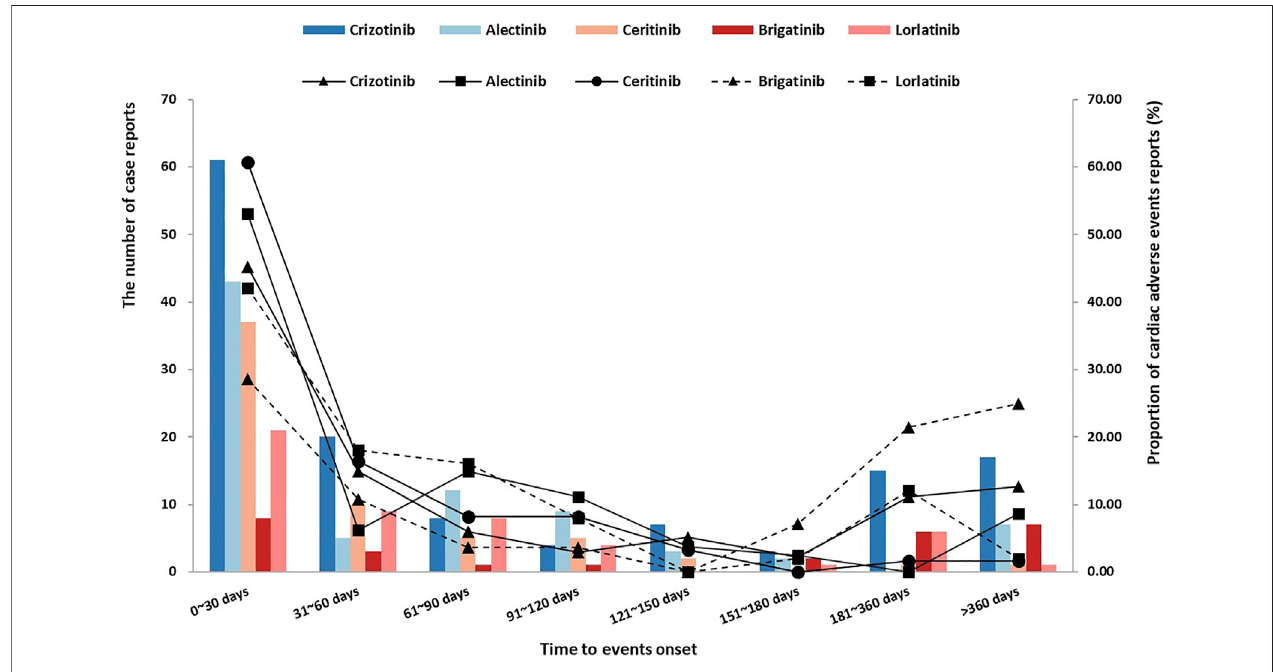
FIGURE 1 | Time to ALK-TKI-associated cardiac disorder onset.